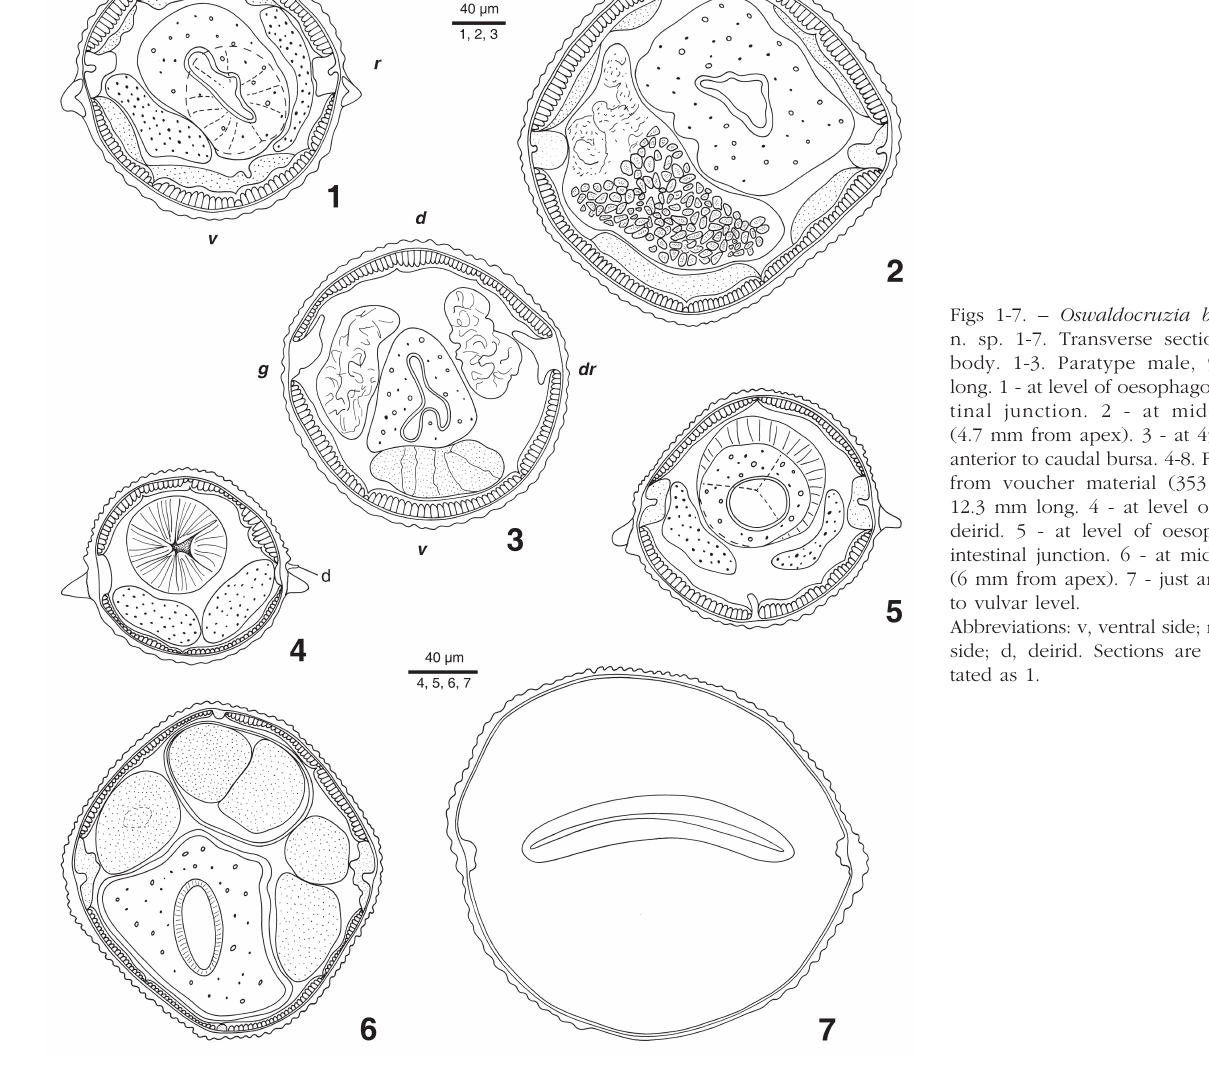
Figs 1-7. – Oswaldocruzia burseyi n. sp. 1-7. Transverse sections of body. 1-3. Paratype male, 9 mm long. 1 - at level of oesophago-intes- tinal junction. 2 - at mid-body (4.7 mm from apex). 3 - at 450 µm anterior to caudal bursa. 4-8. Female from voucher material (353 MQ), 12.3 mm long. 4 - at level of right deirid. 5 - at level of oesophago- intestinal junction. 6 - at mid-body (6 mm from apex). 7 - just anterior to vulvar level. Abbreviations: v, ventral side; r, right side; d, deirid. Sections are orien- tated as